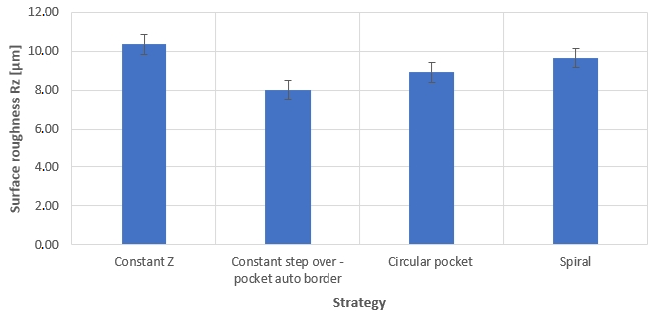
Figure 33. Comparison of roughness parameter Rz.